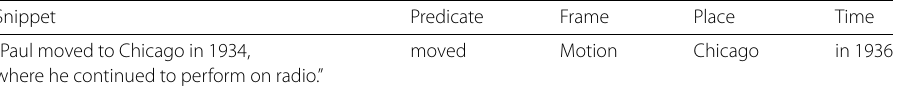
Table 2 Example of identification and classification of a sentence using Semaphor and FrameNet Snippet